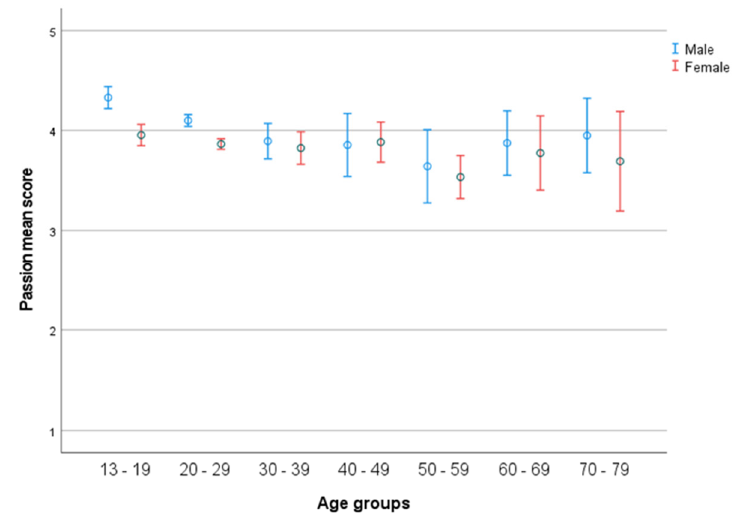
Figure 2. Passion across life-span in the seven age groups in relation to gender. Error bars represent 95 CI.